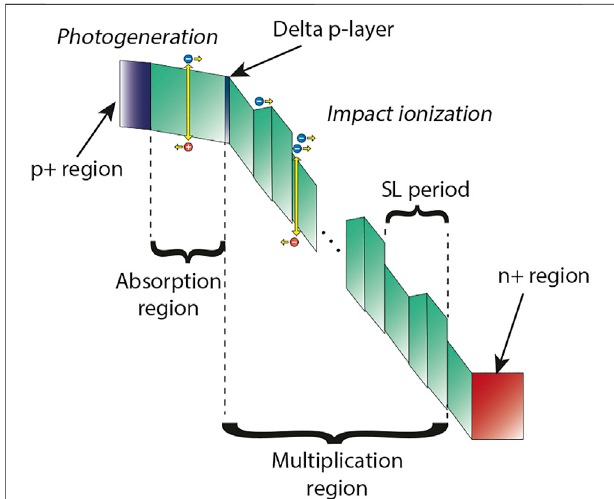
FIGURE2| Sketch oftheband-diagram ofaSAM-APD. Theabsorption region (GaAs in the results reported in the following), where generation of e-h pairs by photon absorption occurs, is separated from the multiplication region (where impact ionization events take place) by a δ layer with p doping. The multiplication region consists of a